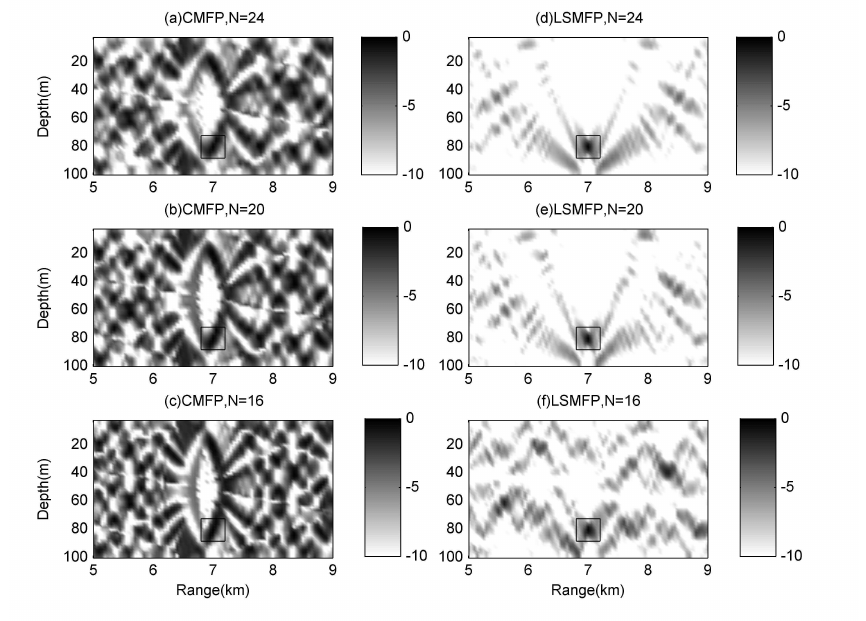
Figure 4. Comparison among ambiguity surfaces of three small arrays. ( a – c ) are ambiguity surfaces of 2#, 3#, 4# array for CMFP method; ( d – f ) are ambiguity surfaces of 2#, 3#, 4# array for LSMFP